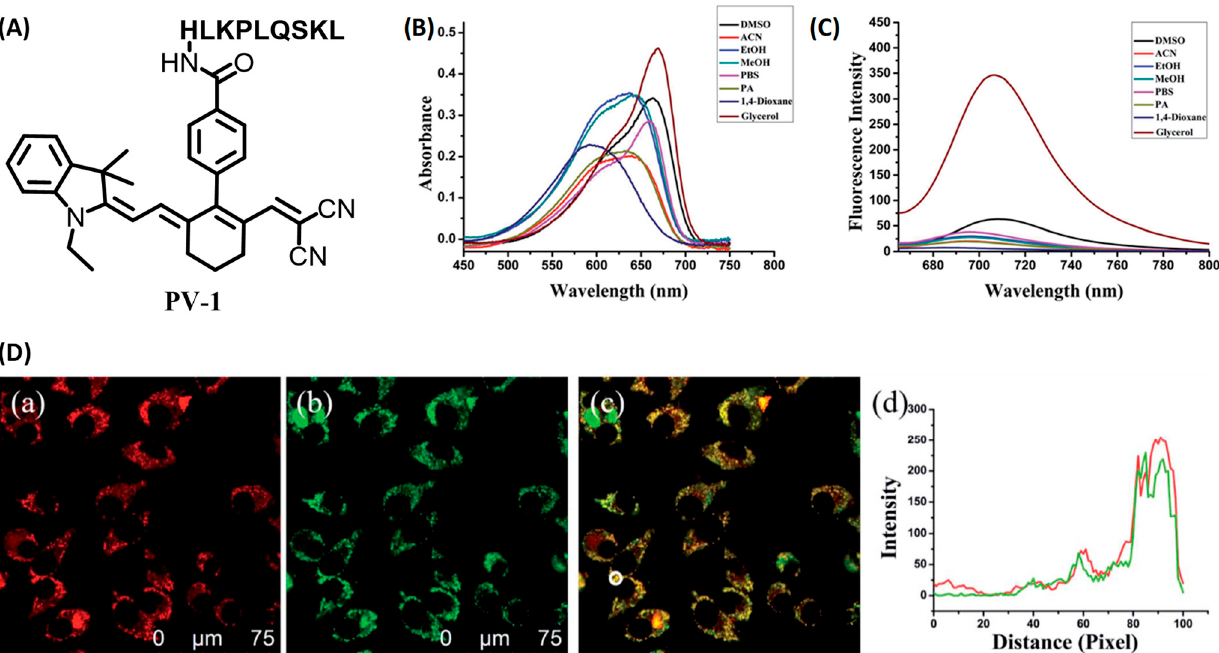
Figure 5. ( A ) The structure of probe PV-1 . ( B ) Ultraviolet spectra of PV-1 (5.0 mM) in different solvents, respectively. λ ex = 650 nm. ( C ) Fluorescence spectra of PV-1 (5.0 mM) in different solvents, respectively. λ ex = 650 nm. ( D ) ( a – c ) Confocal fluorescence images of the SMMC-7721 cells incubated with PV-1 and peroxisome-GFP. ( a ) Fluorescence image from PV-1 ( λ ex = 633 nm, λ em = 650–750 nm); ( b ) fluorescence image from peroxisome-GFP ( λ ex = 488 nm, λ em = 495–550 nm); ( c ) merged images; and ( d ) intensity profile of ROI lines of the white circle. Scale bar = 75 mm. [34] Copyright © 2023 Royal Society of Chemistry.